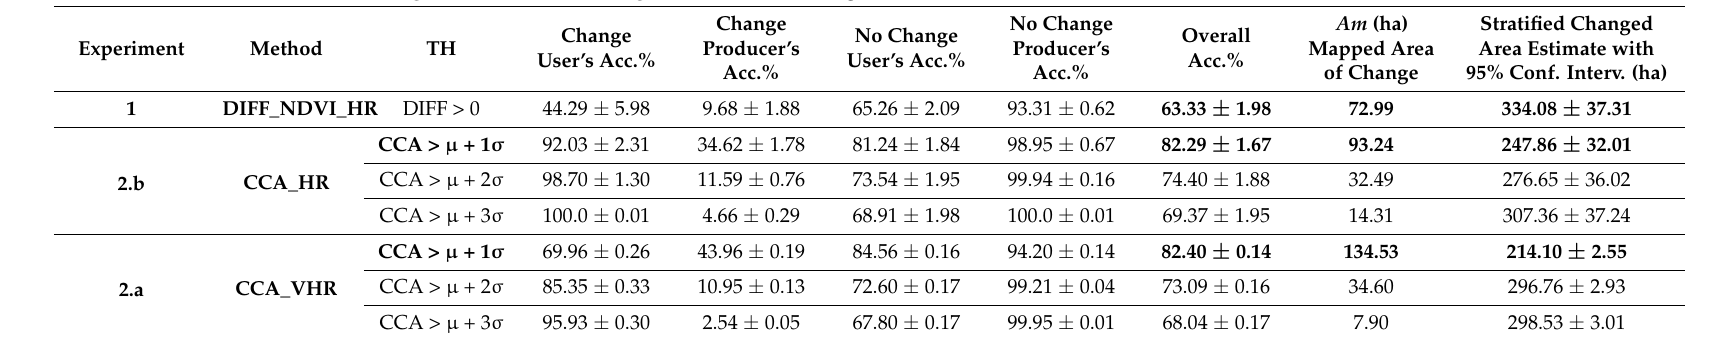
Table 4. Change detection matrix for the evergreen tropical forest in Indian site. Results obtained by CCA_HR and CCA_VHR. Producer’s and overall accuracy values are based on stratified estimation. TH indicates the threshold applied to the Z-statistic image in the CCA experiments. A m is the mapped changed area. Change: Transition from Evergreen Forest to No Evergreen Forest— at Different TH for an Area of 911 ha (at T 1